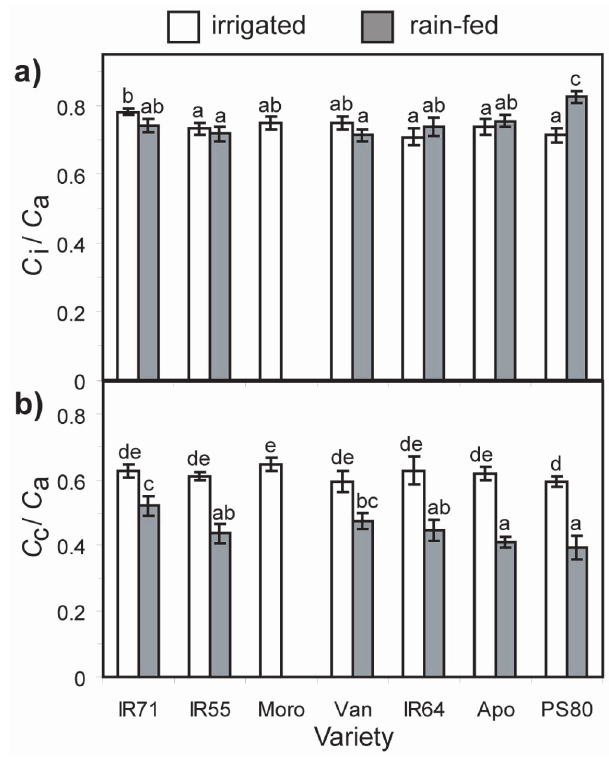
Figure 4. Measurements of (a) the intercellular [CO 2 ] ( C i ) to the ambient [CO 2 ] ( C a ) ratio ( C i / C a ), and (b) the chloroplastic [CO 2 ] ( C c ) to the ambient [CO 2 ] ratio ( C c / C a ) in control and water- stressed leaves of the seven Oryza sativa genotypes. The measurements were made on the flag leaf in saturating PPFD (1400 m mol m 2 2 s 2 1 ), with relative humidity ranging between 45–55%, and a leaf temperature of 30 u C. Data are means of 4 to 7 plants per treatment. Error bars as in Figure 1. Different letters denote significant differences among means derived using a factorial ANOVA and Tukey post-hoc